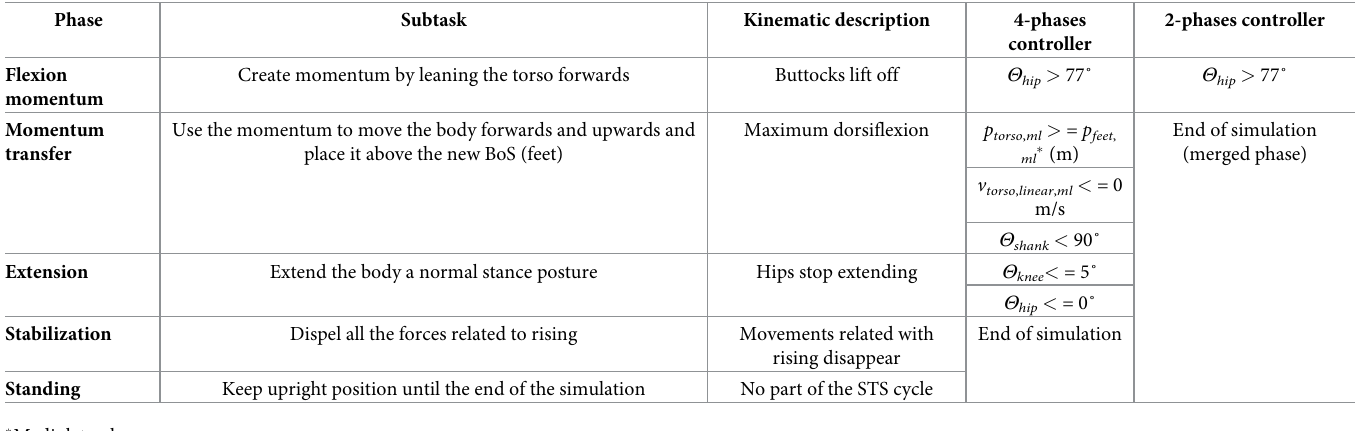
Table 1. Subtask and end of the kinematic and the modelled